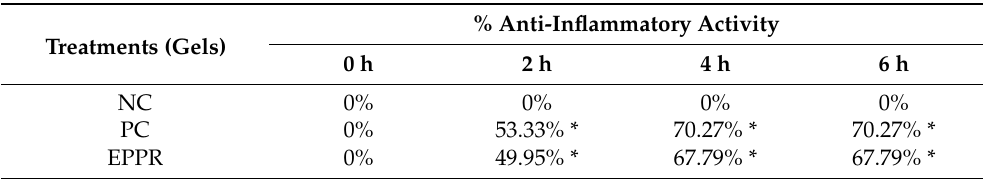
Table 4. Anti-inflammatory activity of the gels in mean percentage, represented by the ability to inhibit carrageenan-induced paw edema at different time